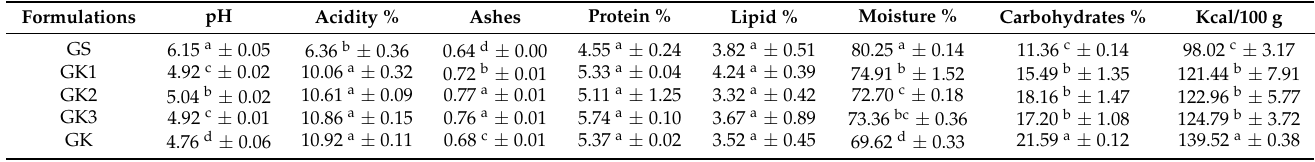
Table 3. Physicochemical analysis and caloric value of the five ice cream formulations (g/100 g).